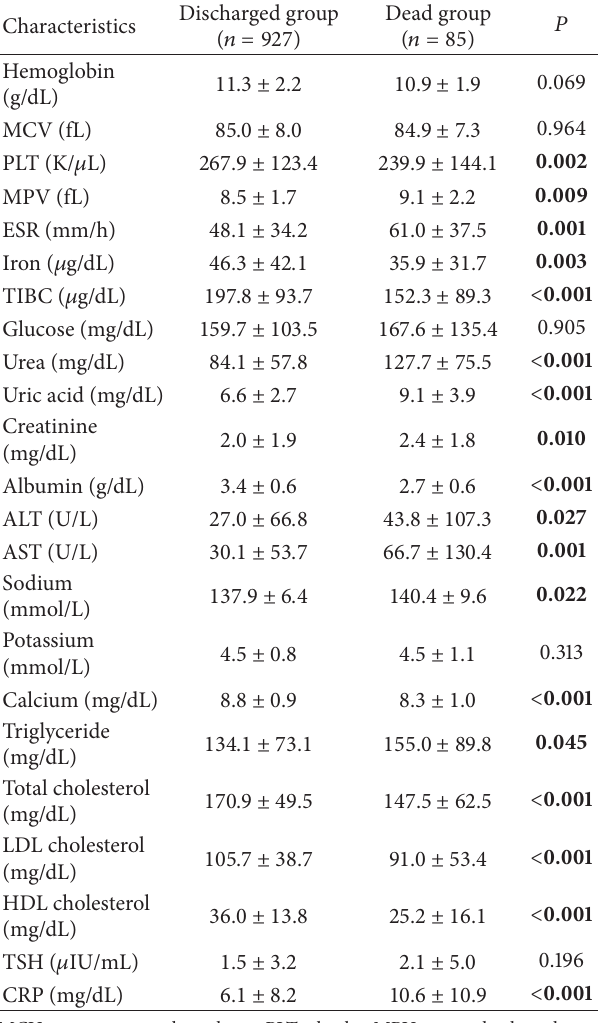
Table 3: Laboratory values of the discharged and dead groups at the time of